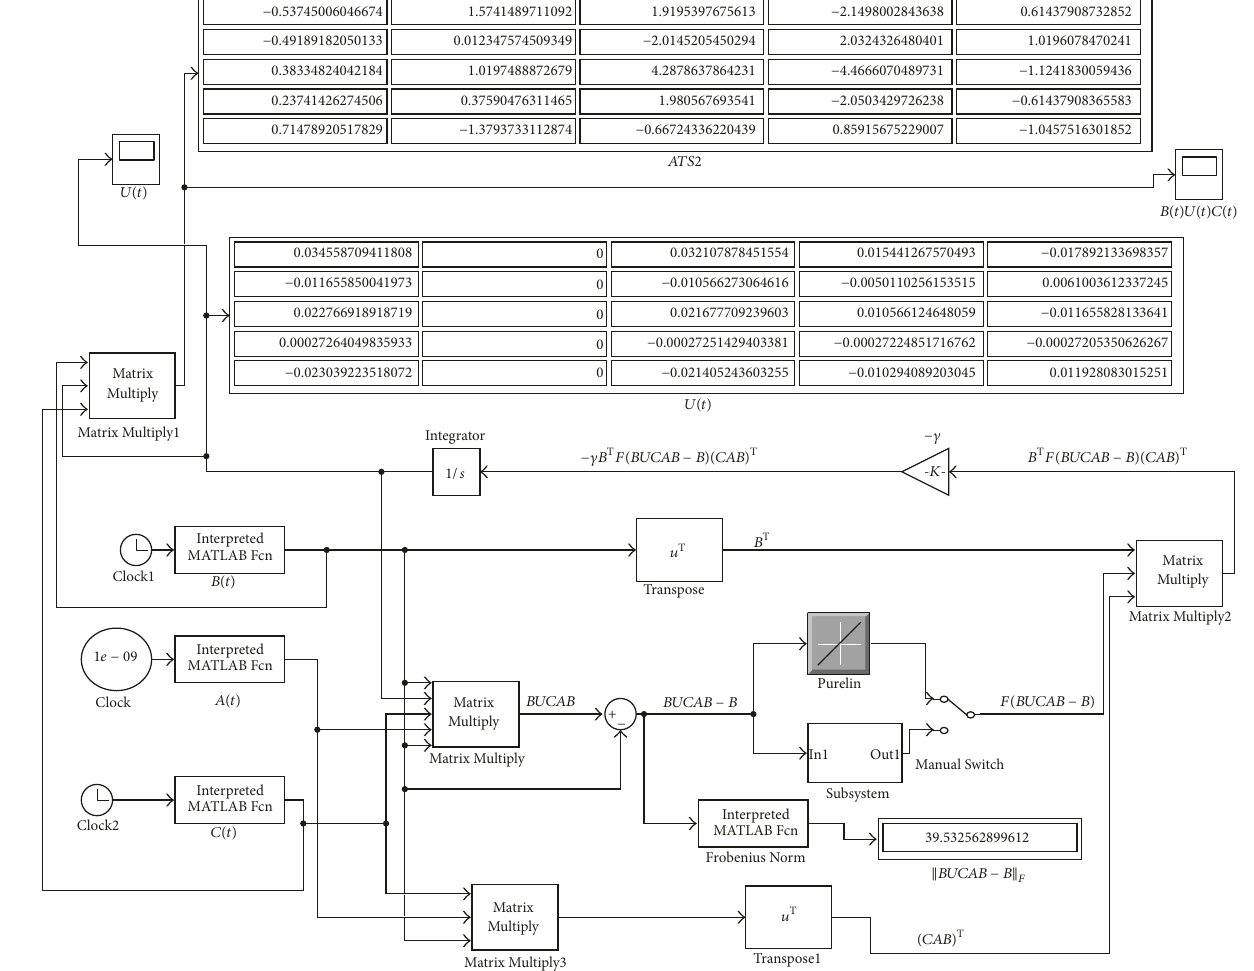
Figure 13: The implementation of Algorithm 3 when its conditions are not